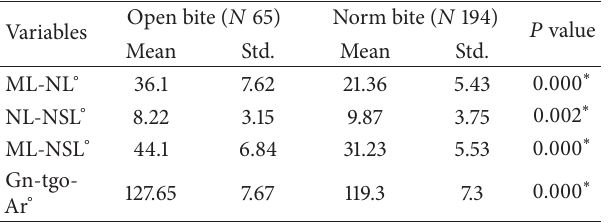
Table 6: The skeletal vertical variables for open bite and norm Yemeni adults.